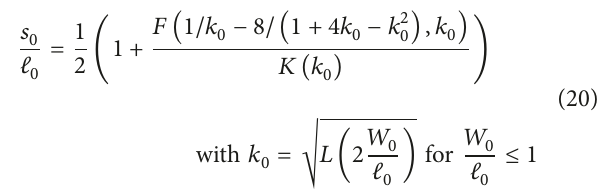
/ℓ ≈ 0.55 . The dependence on contact 0 0